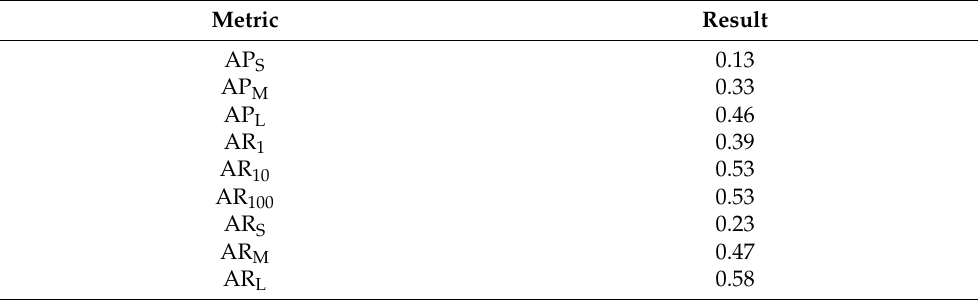
Table 6. Values of AP and average recall (AR) variations for different object sizes and number of detections per